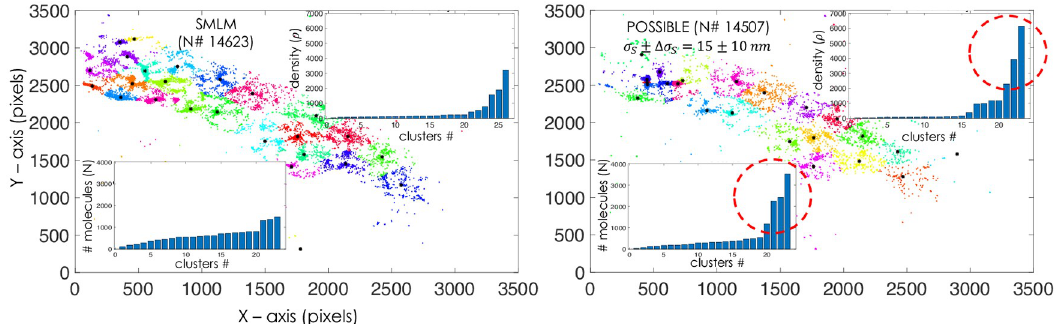
Fig 5. Cluster analysis using K-means clustering algorithm for SMLM and POSSIBLE microscopy (with filter, G ( σ Cluster density and HA number analysis are also shown in the inset. Other important parameters such as, cluster area, molecule packing and cluster-spread density are discussed in Supplementary 2-4 of S1 File. The red circle indicates high-density and large molecule clusters for POSSIBLE reconstructed images ( G ( σ